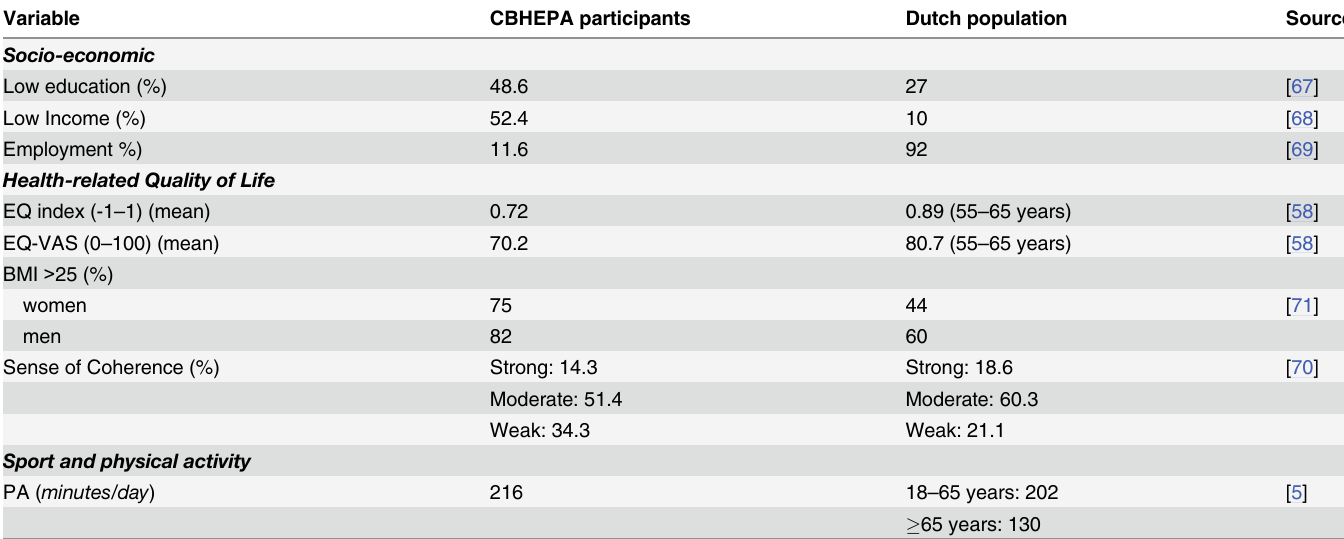
Table 9. Comparison of CBHEPA participants at baseline with Dutch population